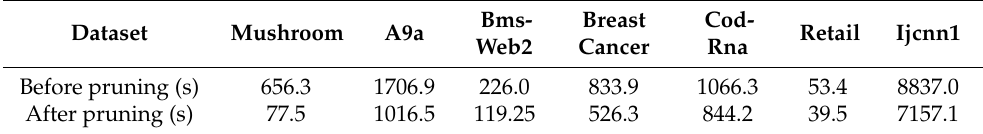
Table 9. Time comparison before and after pruning.